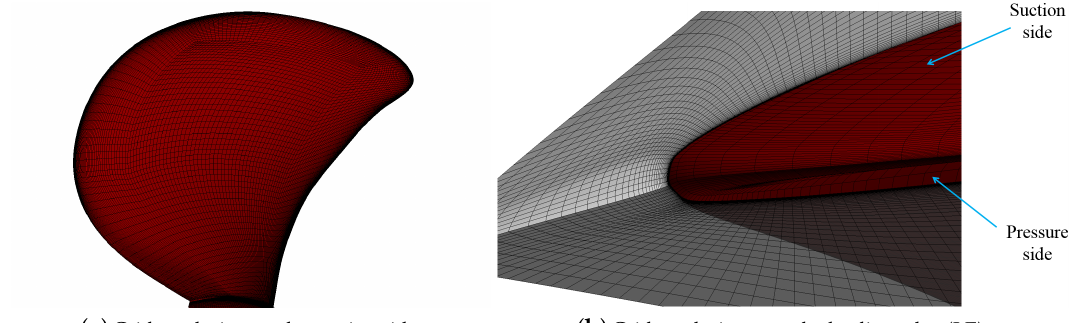
( a ) Grid resolution on the suction side. Figure 4. Grid resolution on the suction side and near the leading edge of the blade.